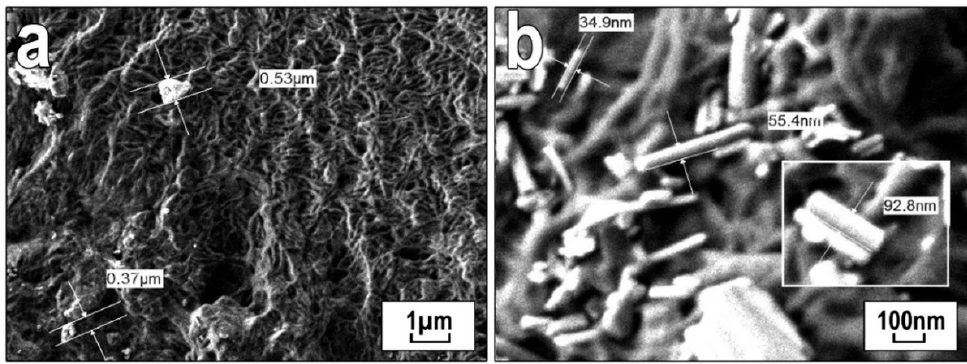
Figure 7. Microphotographs of supramolecular structure of PCM based on UHMWPE with an addition of 1.0 wt.% of wollastonite: ( a ) ×5000 and ( b ) ×30,000. addition of 1.0 wt.% of wollastonite: ( a ) × 5000 and ( b ) × 30,000.